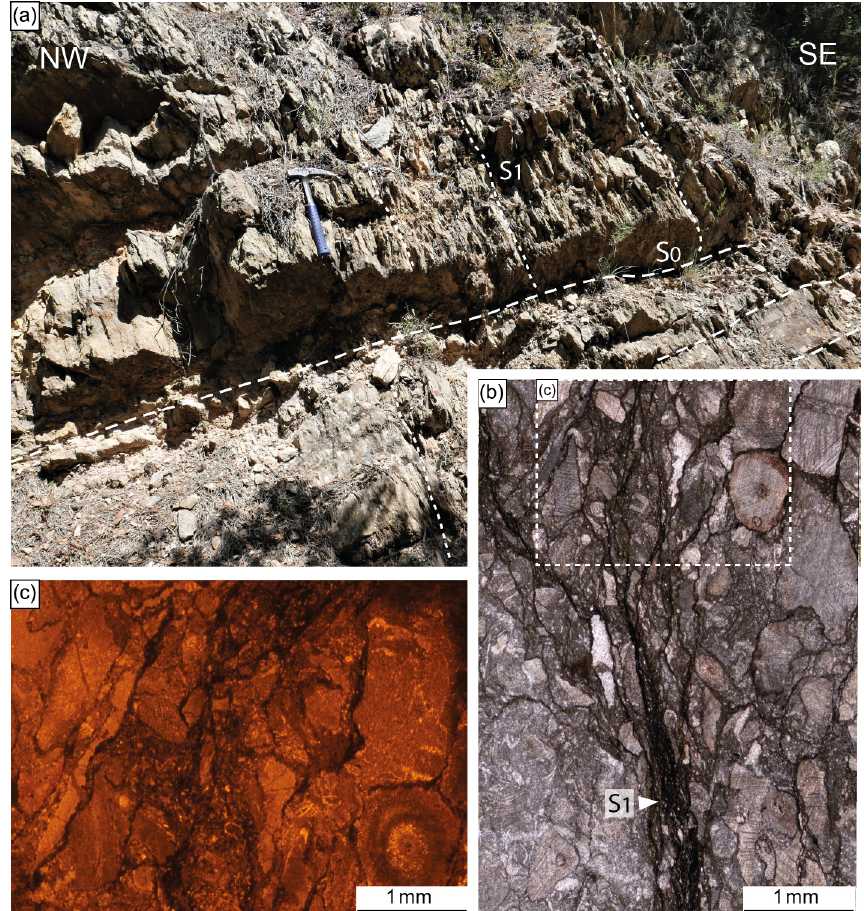
Figure 5. Devonian protolith. (a) Field image showing the relationship between bedding (S 0 ) and regional foliation (S 1 ). (b) Plane-polarized light and (c) cathodoluminescence microphotographs of the encrinites alternating with pelitic-rich bands, where the S 1 is